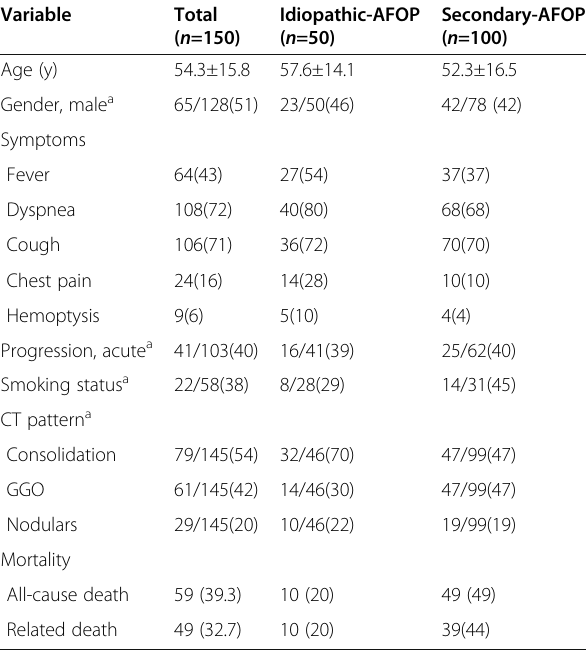
Table 1 Clinical characteristic and prognosis of patients